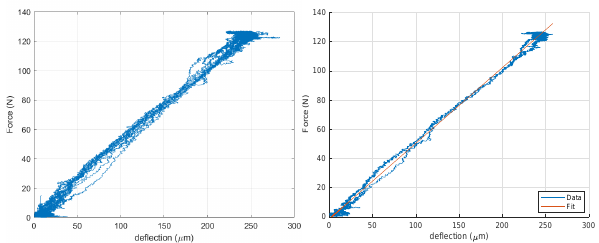
Figure 22: 6-DOF Industrial Robot: Force versus de- flection. Load in y-direction with 220 mm